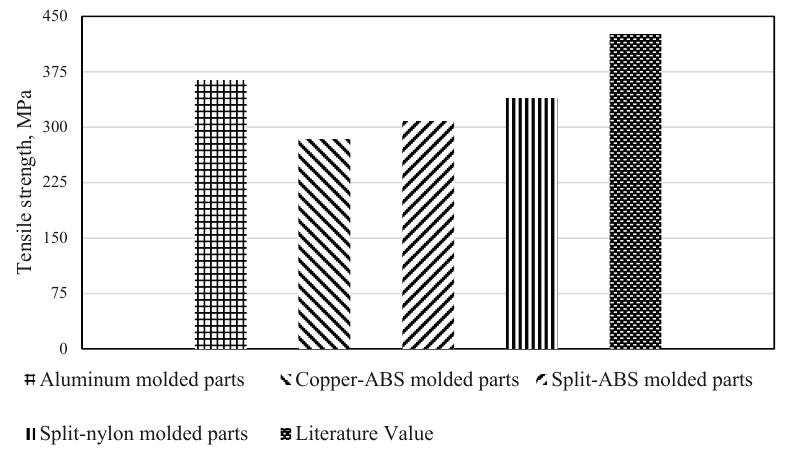
Figure 13. Comparison of tensile strength, and sintered parts with benchmark and literature.